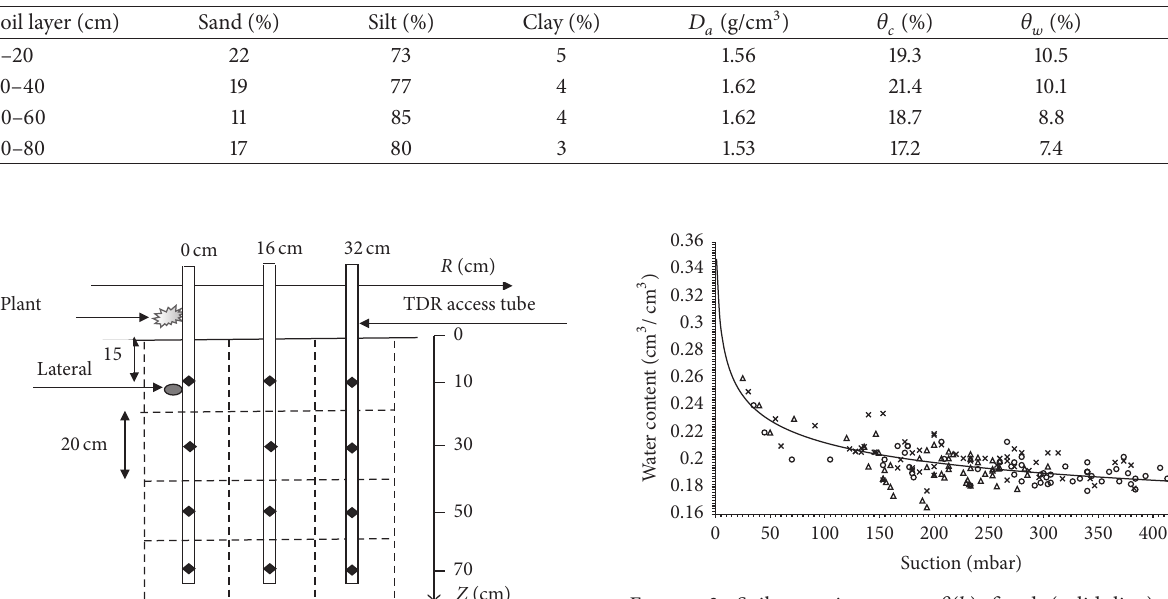
Table 1: Soil physical characteristics.